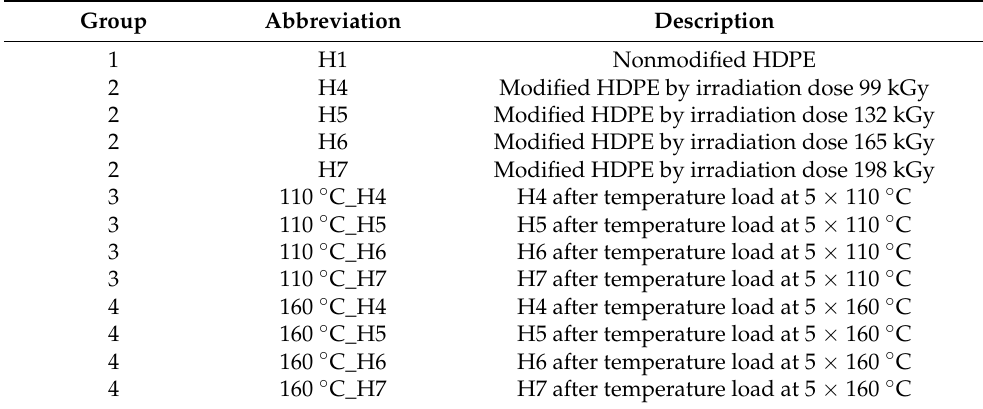
Table 2. Abbreviations and description of used specimens for dynamic tensile test.